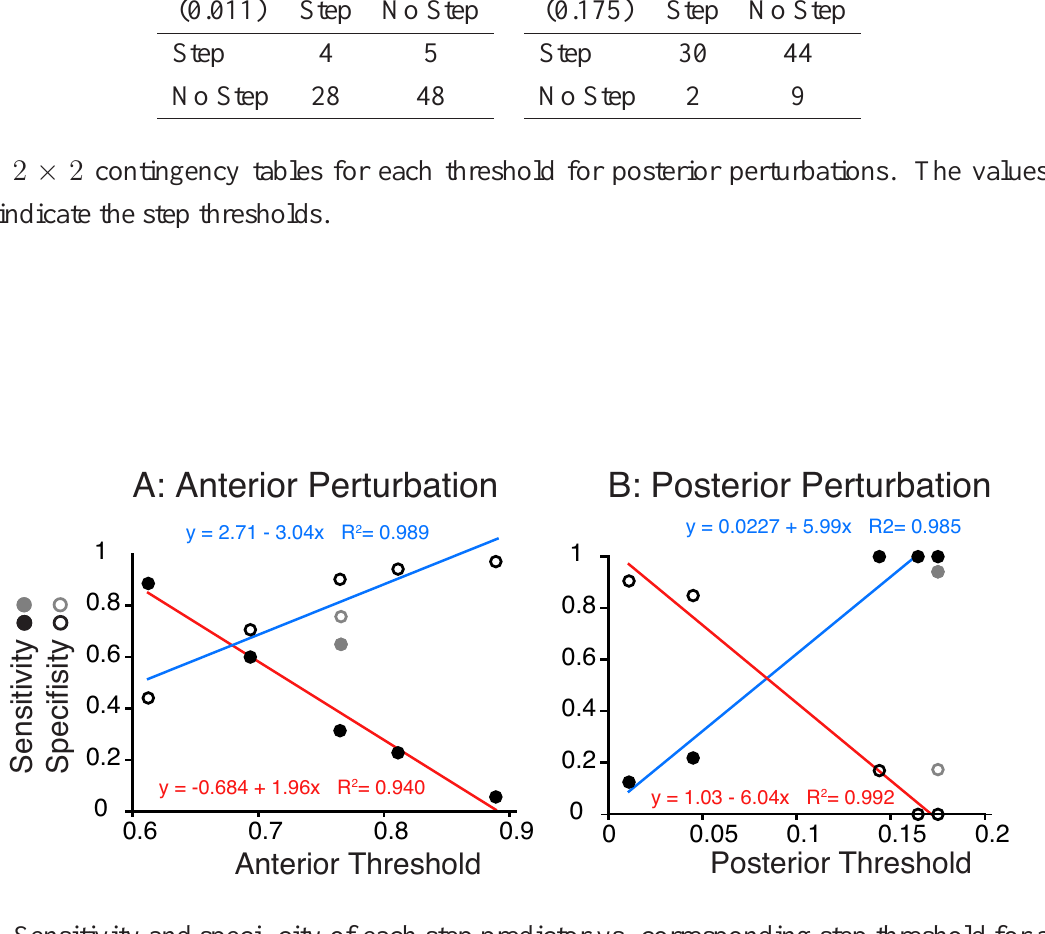
Figure 3 . Sensitivity and specificity of each step predictor vs. corresponding step threshold for anterior (A) and posterior (B) perturbations. The grey plots represent the sensitivity and specificity of the static